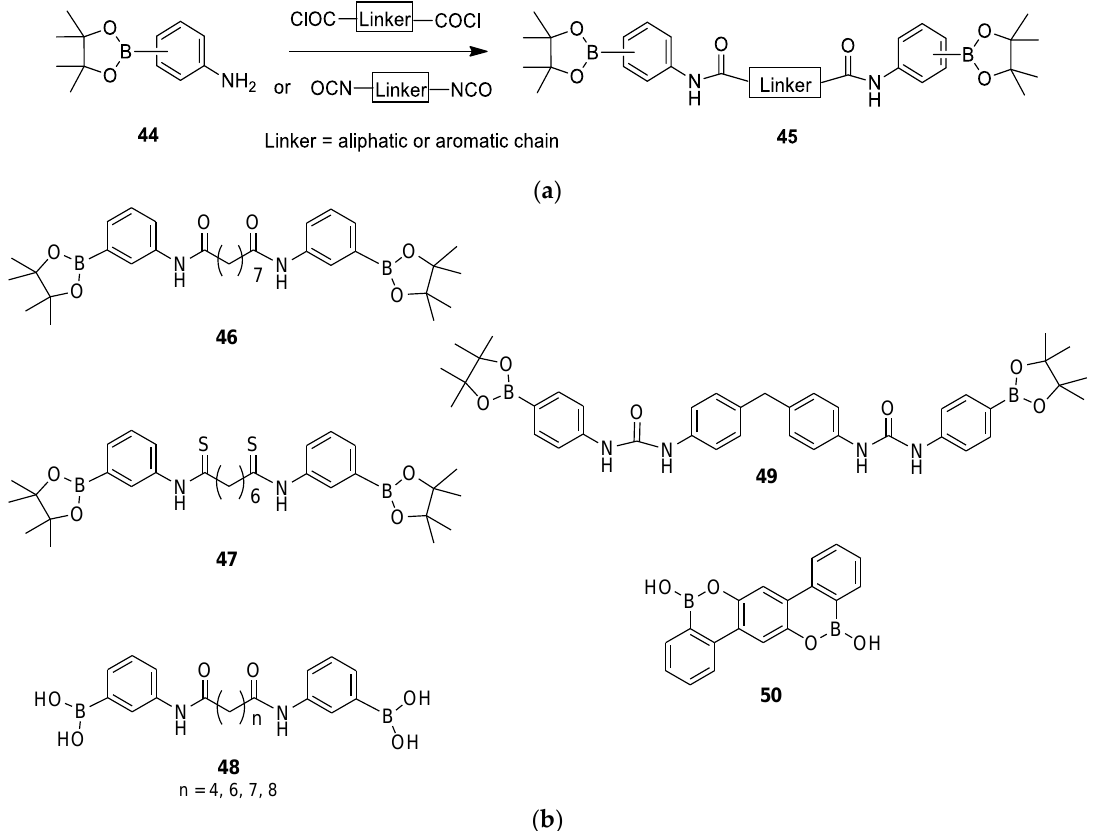
Figure 11. ( a ) Preparation of the phenyl boronic acid pinacol esters 45 . ( b ) Symmetric phenyl boronic acids ( 48 , n = 4, 6, 7, 8), pinacol esters ( 46 , 47 , 49 ), and compound 50 .